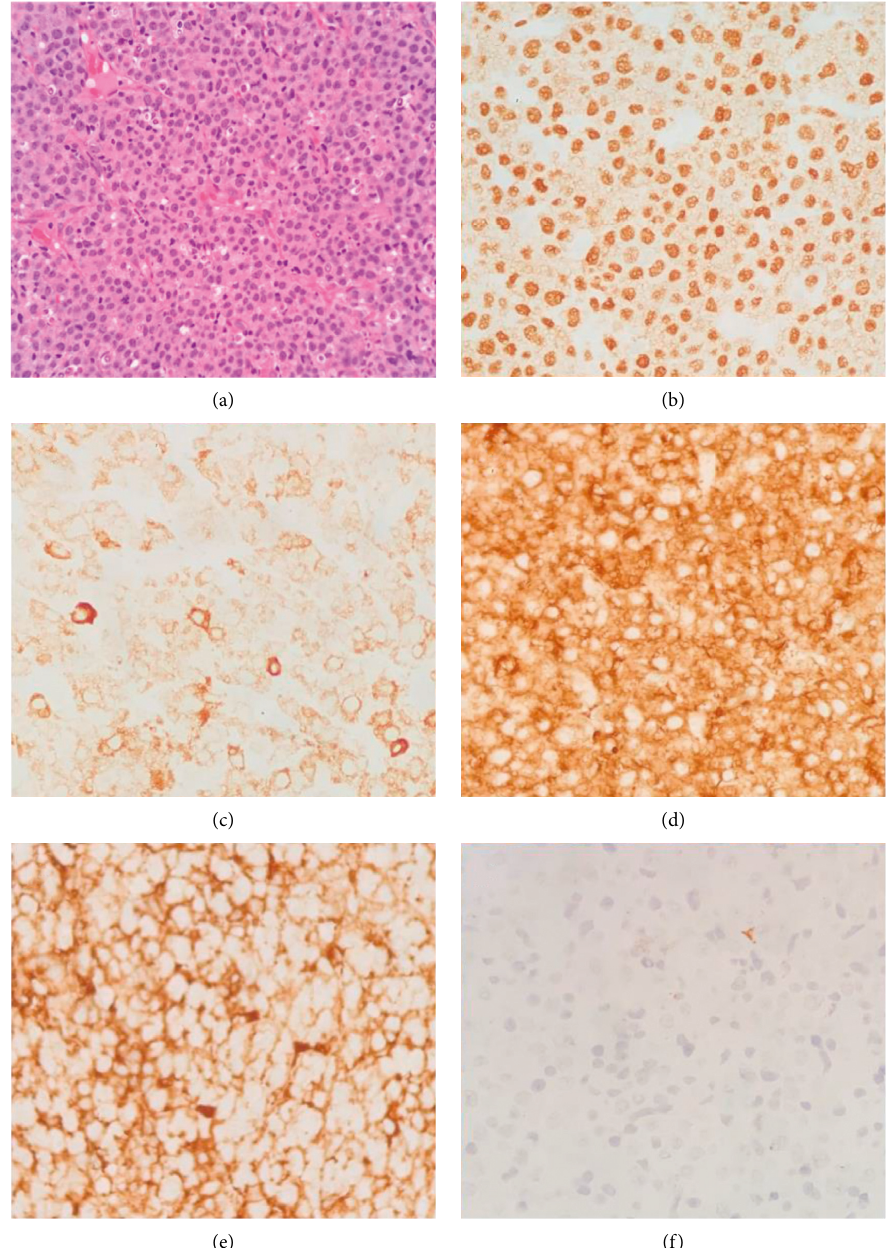
Figure 2: Nasopharyngeal mass biopsy. Hematoxylin and eosin staining ((a) original magnification × 40) and immunohistochemical staining were positive for MUM-1 ((b) original magnification × 40), CD79a ((c) original magnification × 40), kappa ((d) original mag- nification × 40), and lambda ((e) original magnification × 40) and negative for CD20 ((f) original magnification ×